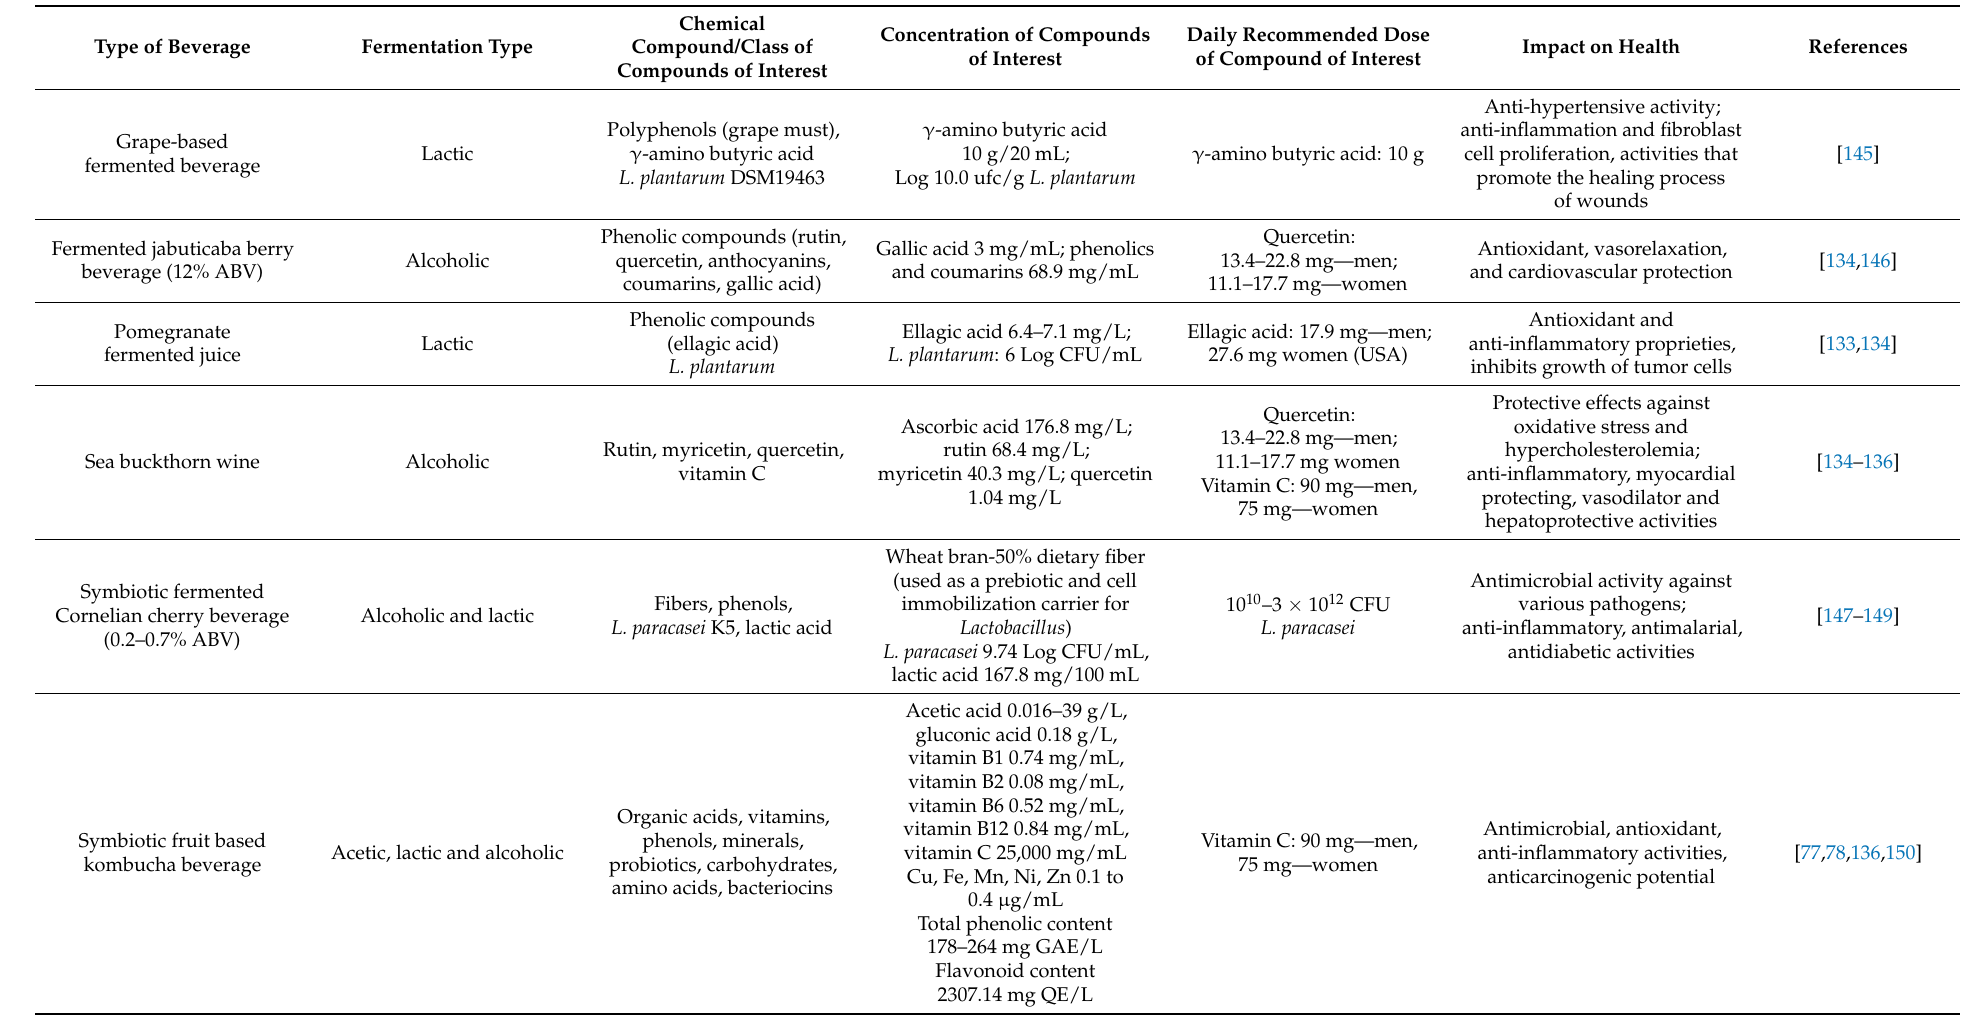
Table 3. Content of the main compounds of interest, daily recommended dose, and health effects of fermented beverages from different